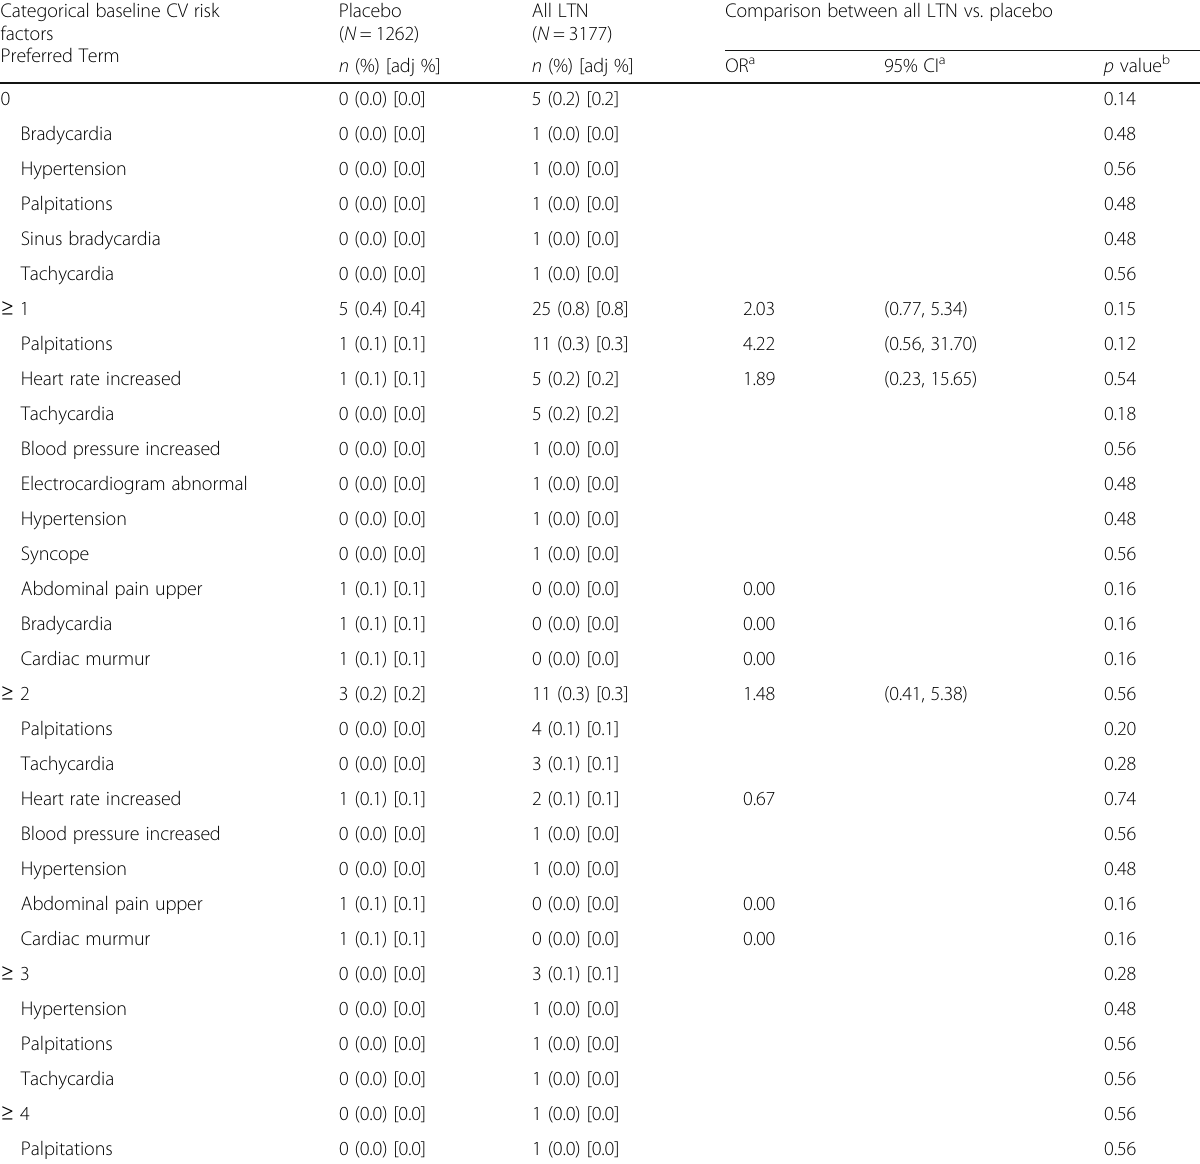
Table 4 Summary and analysis of likely cardiovascular treatment-emergent adverse events by cardiovascular risk factor categories Categorical baseline CV risk factors Preferred